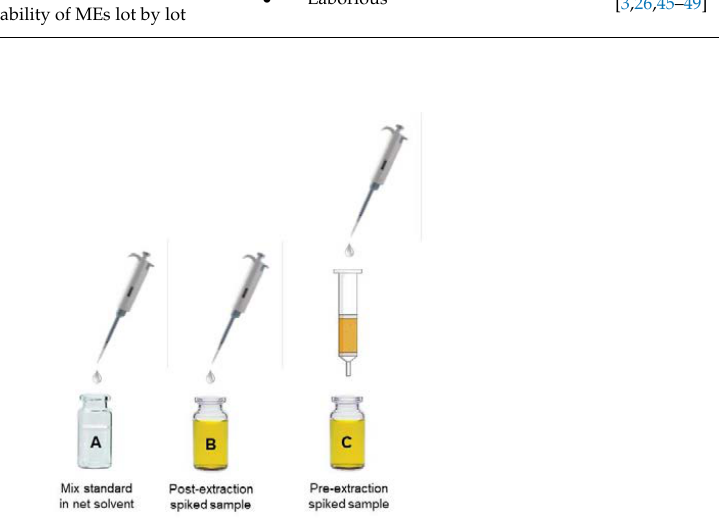
Figure 2. Qualitative evaluation of MEs by post-column infusion method on the compound ( A ). Comparison between two common protein precipitation agents on a blank plasma sample: ( B ) acetonitrile, and ( C ) perchloric acid. Acetonitrile generally gave less signal suppression among the entire chromatographic profile, and in particular in the elution zone of the compound A (unpublished data).